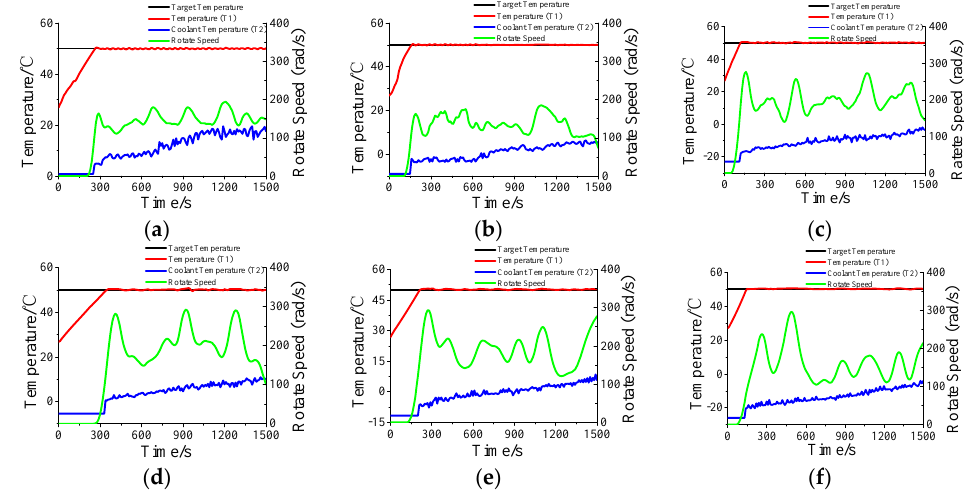
Figure 7. The temperature of other liquids at different microwave irradiation power: ( a – c ) the temperature of ethanol was controlled to 50 °C under 50, 70, and 100 W; ( d – f ) the temperature of methanol was controlled to 50 °C under 50, 70, and 100 W.